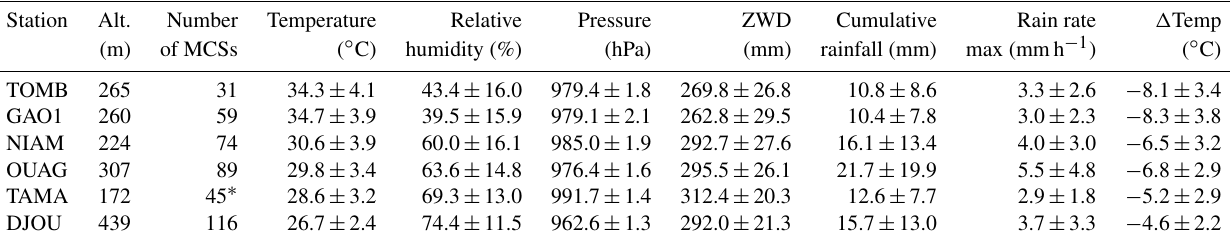
Table 3. Statistics (mean ± one standard deviation) for 414 MCS events detected at the AMMA GPS stations during JJAS from 2006 to 2008. Characteristics of the atmospheric environment before the MCS: surface air temperature, pressure, and relative humidity from PTU200 sensors, and ZWD from GPS receivers (these variables are averaged over the 5h before the cold pool crossing time). Cumulative rainfall depth and the maximum rain rate from the TRMM Multisatellite Precipitation Analysis (Huffman et al., 2007). The last column gives the maximum temperature drop, (cid:49) Temp, within the 1h following the cold pool crossing